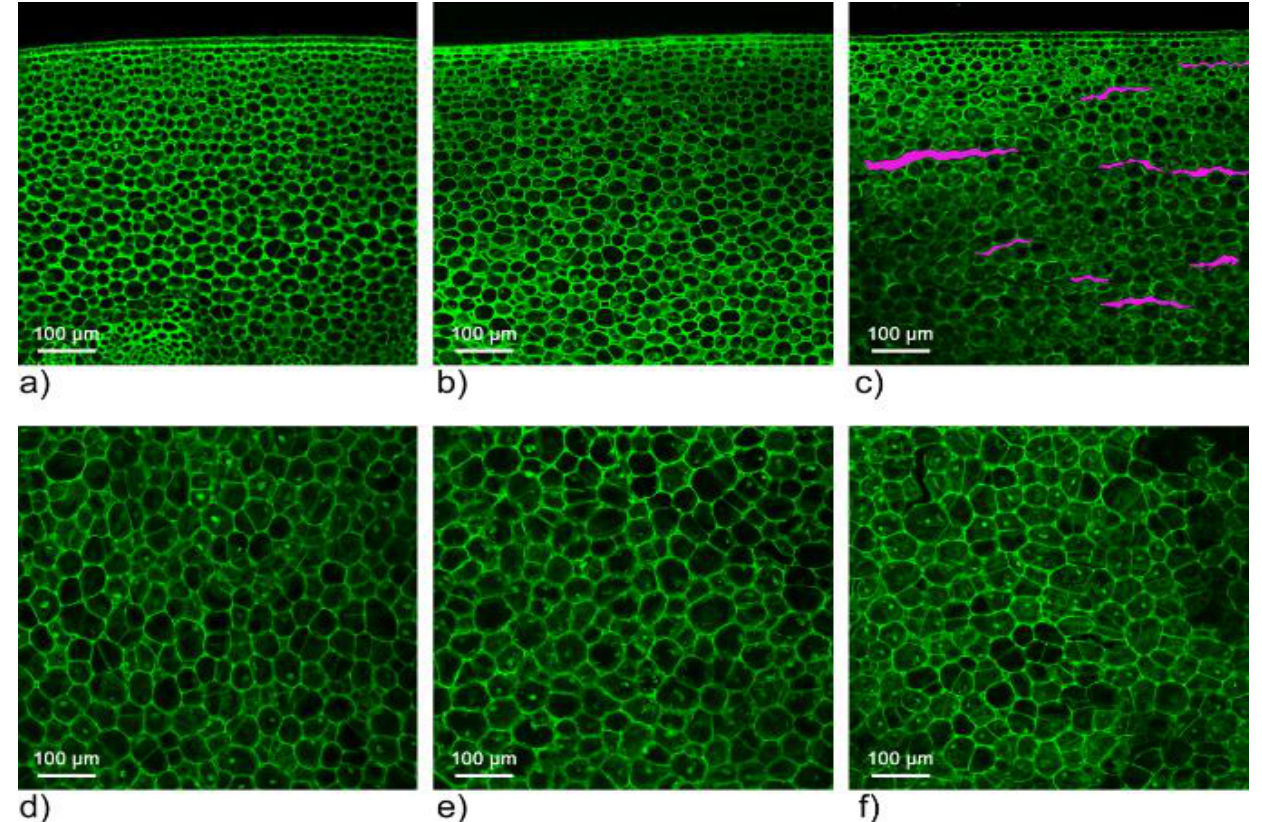
Figure 2. Microscopic images of broccoli tissue made in a plane perpendicular to the axis of the stem for three types of samples: ( a , d ) control sample, ( b , e ) sample subjected to rapid freezing in liquid nitrogen, ( c , f ) sample subjected to slow freezing (−20 °C). Characteristic tissue damage that occurs during slow freezing of samples has been highlighted in a separate colour in part ( c ).